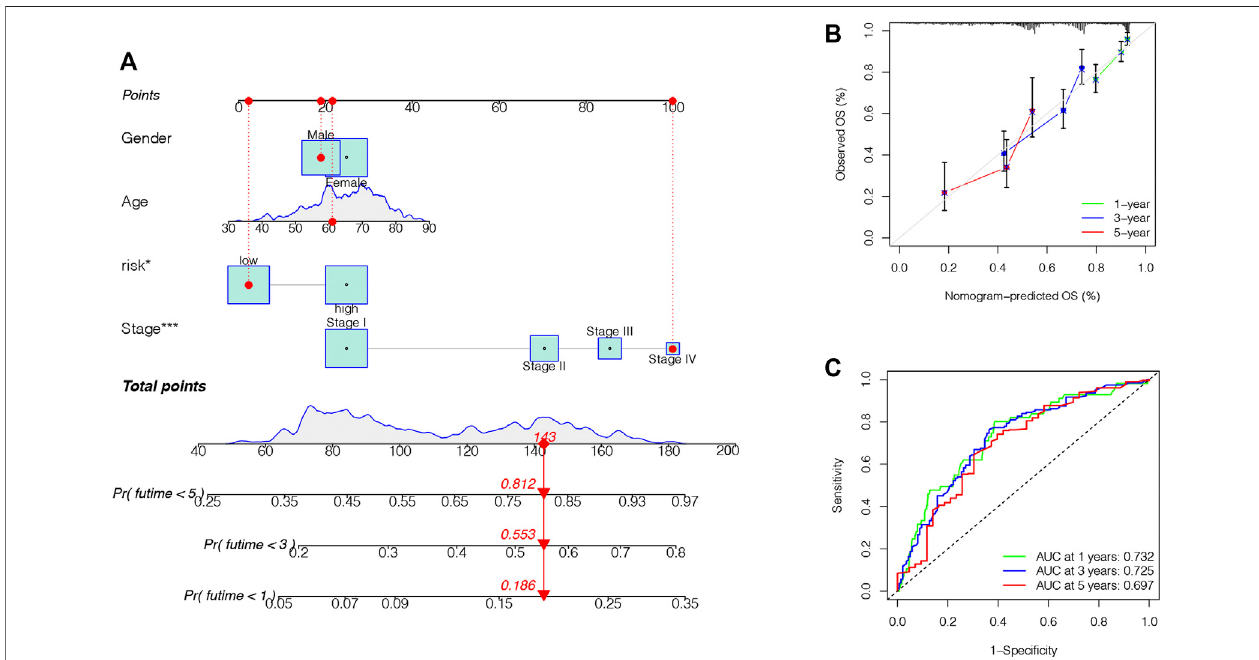
FIGURE9| Construction andvalidationofanomogram. (A) . Nomogram forpredicting the1-,3-,and 5-year OSofLUADpatients. (B) .ROCcurve and AUCofthe predictions for 1-, 3-, and 5-year OS in the TCGA cohort. (C) . Calibration curves of the nomogram for the TCGA cohort.